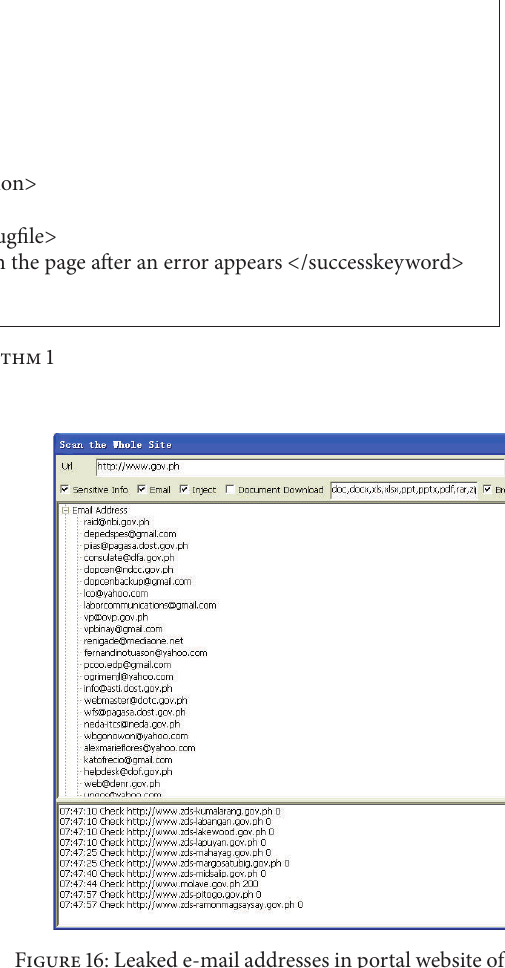
Figure 16: Leaked e-mail addresses in portal website of Philippines.